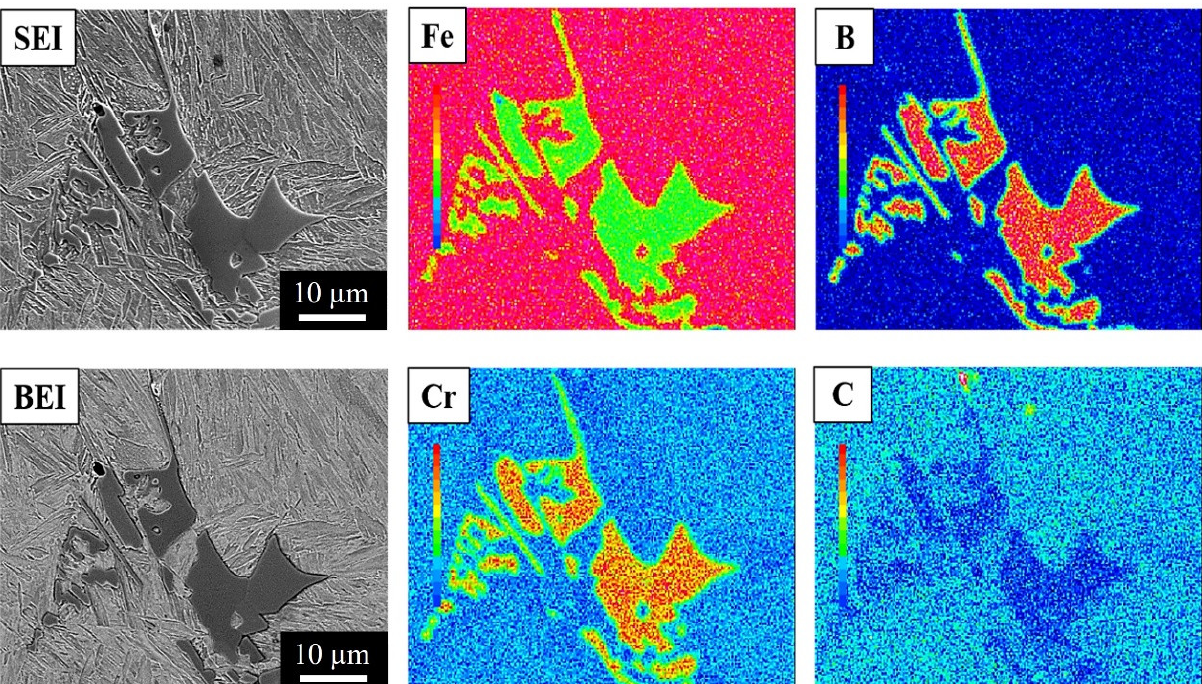
Figure 7. EPMA elemental distributions of 410L + 0.6B steel sintered at 1250 °C for 1 h in hydrogen.